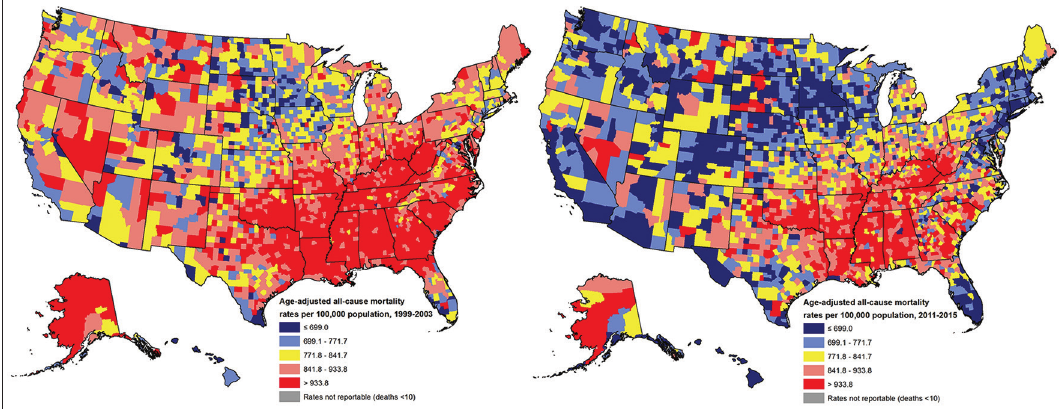
Fig ure 14. Age-Adjusted All-Cause Mortality Rates per 100,000 Population for the United States (3,143 Counties), 1999-2003 and 2011-2015 Source: Derived from the 1999-2015 National Vital Statistics System.